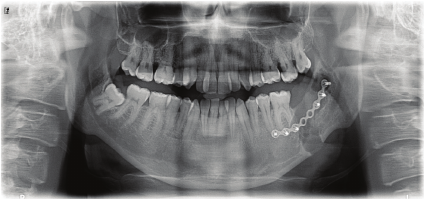
Figure 4: Postoperative panoramic radiography showing rigid fixation of the segments and complete removal of impacted